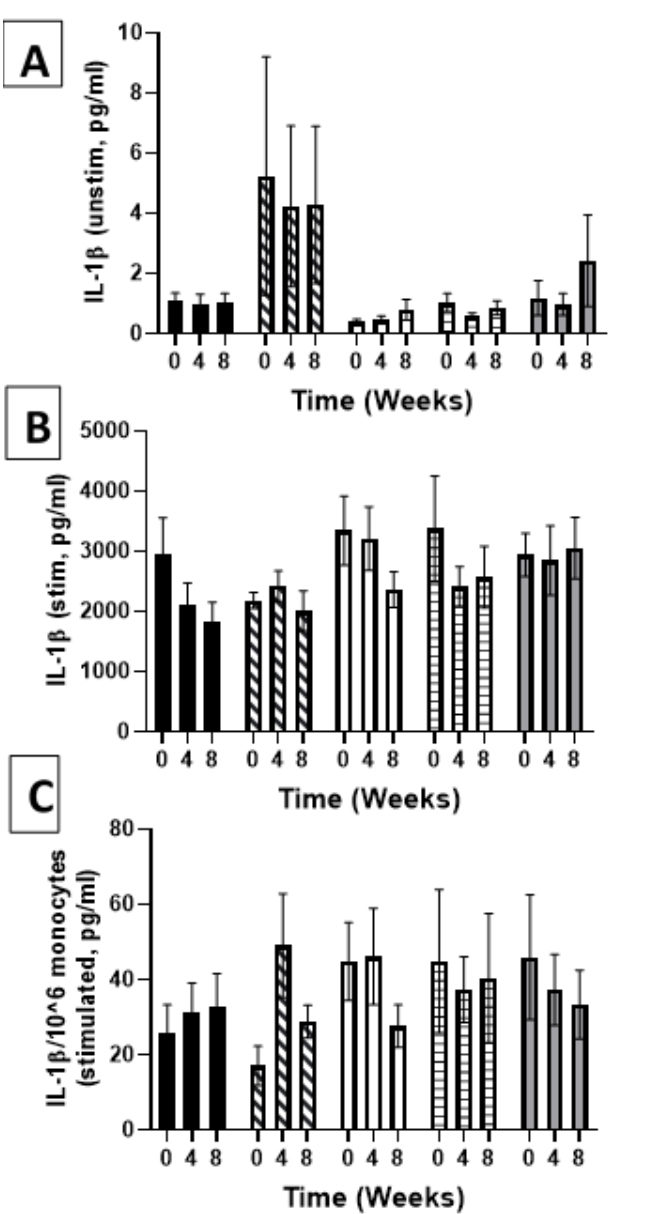
Figure 4. Plasma IL-1 β without stimulation ( A ) and with lipopolysaccharide stimulation ( B ). ( C ) Stimulated samples normalized to monocyte numbers. Values are mean ± SEM, n = 15 per group. Significant changes are indicated where p < 0.05.